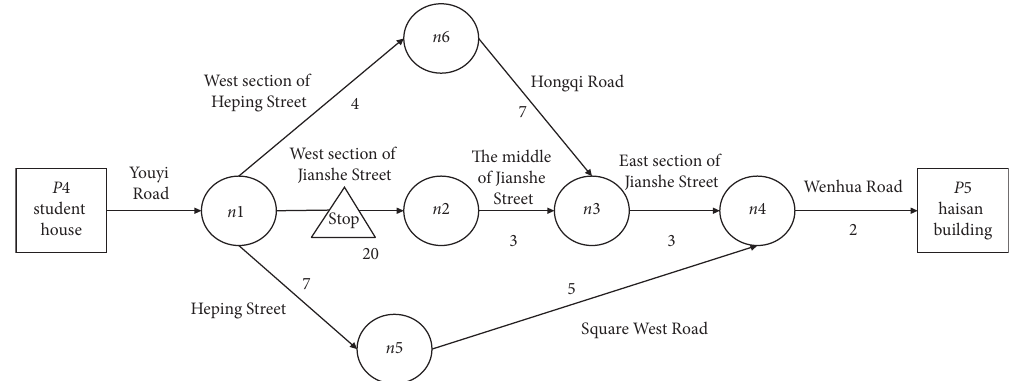
Figure 8: Key points between stops and time consumed on different routes.